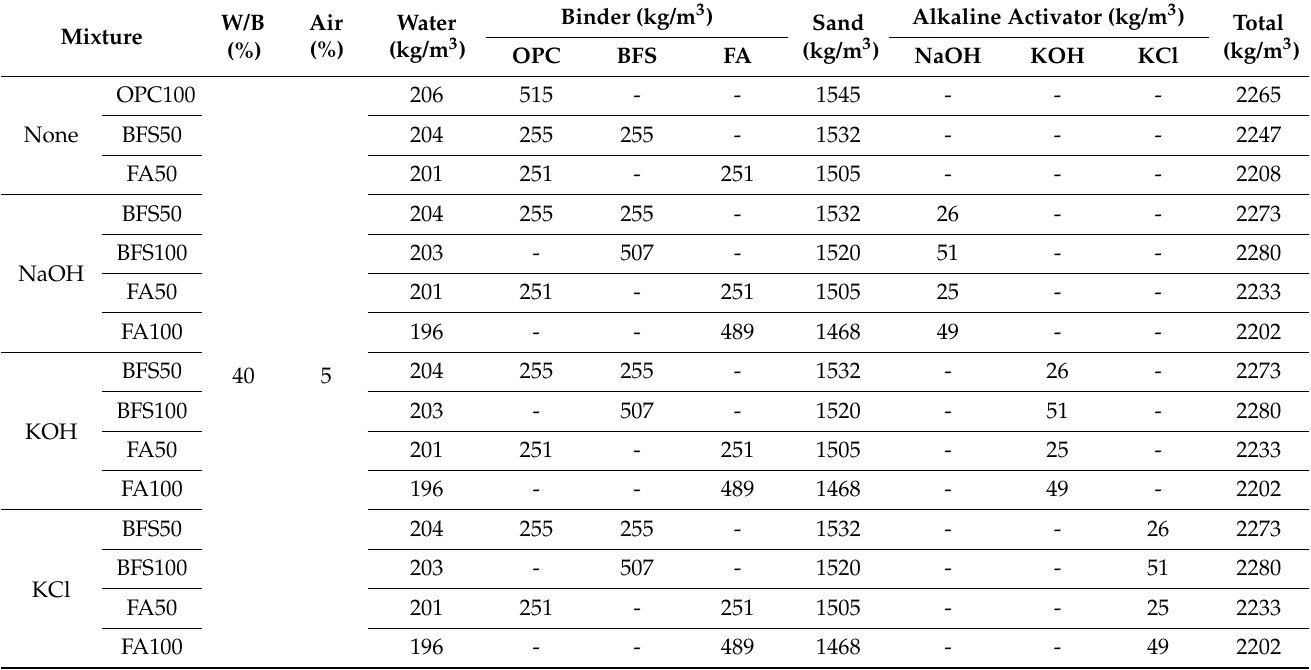
Table 2. Mixtures used to prepare cement-containing and non-cement mortar